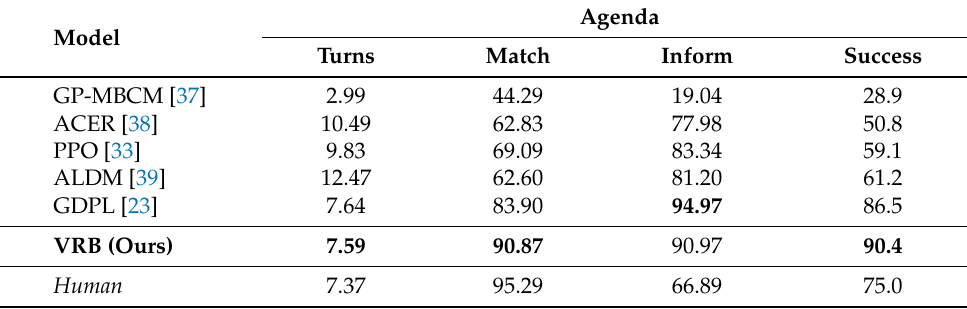
Table 2. Results on agenda-based user simulators.